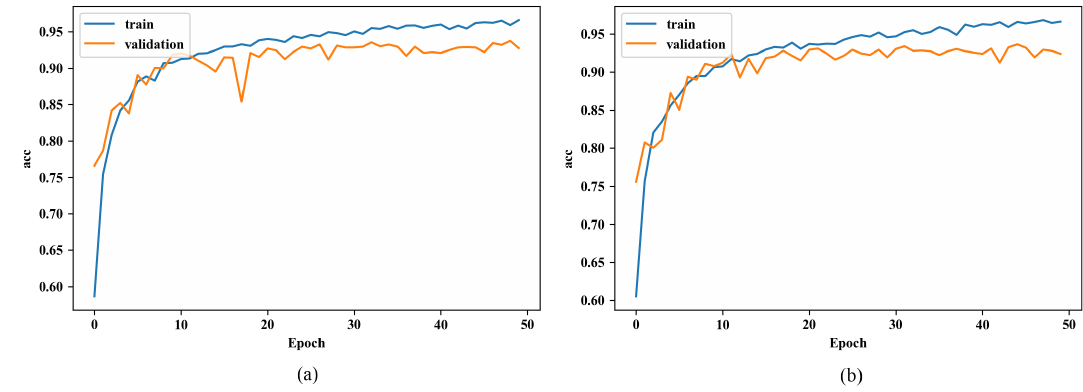
Figure 8. Learning curve of fully connected neural network ( a ) using normal initialization, and ( b ) using RGB-based